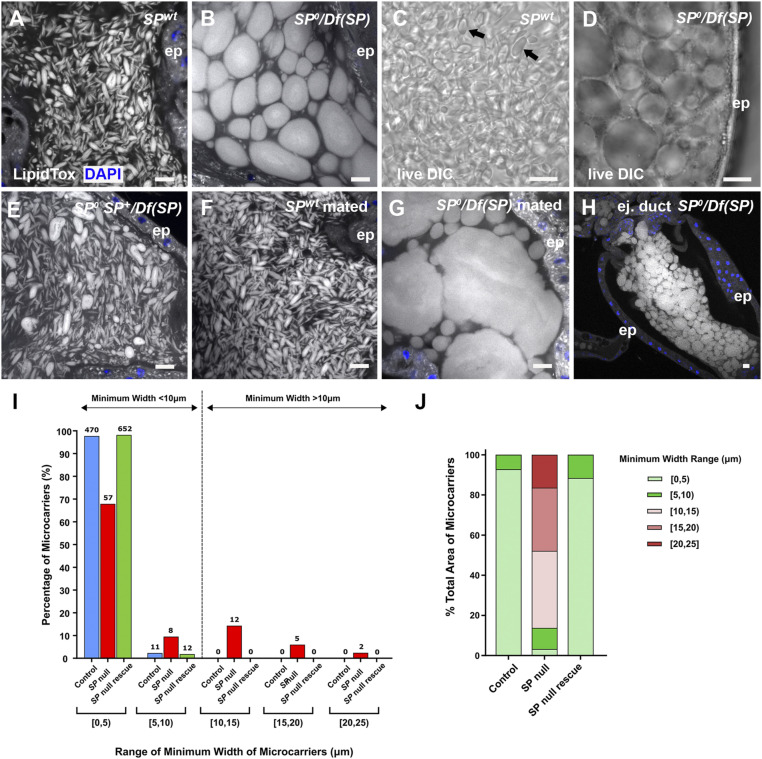
SP is essential for proper assembly of microcarriers. (A and B) Confocal images of LipidTox-labeled microcarriers in lumen of AG from control (A) and SP0/Df(SP) null (B) males. Mutant male has grossly enlarged microcarriers. (C and D) DIC images of living AGs dissected from control (C, black arrows) and SP0/Df(SP) (D) males. (E) Microcarrier structural defects in SP0/Df(SP) null males are rescued by a genomic SP construct SP0
SP+/Df(SP). (F and G) Microcarriers enlarge further after multiple matings in SP0/Df(SP) null (G), but not in wild-type (F) males. (H) In SP0/Df(SP) null males, these enlarged microcarriers are observed when seminal fluid remains in the lumen of the ejaculatory duct after mating. (I and J) Microcarrier size and area profiles for glands shown in A, B, and E. Microcarrier outlines were detected in images of the AG lumen using CellProfiler Software version 2.2.0 (Materials and Methods) and then grouped according to minimum width range (I) or percentage of luminal area occupied by microcarriers in each width range (J). Numbers of microcarriers within each size range are shown above bars (I). SP0/Df(SP) null glands have considerably fewer small microcarriers (<10 µm) and more large microcarriers (>10 µm) than the other genotypes. The enlarged microcarriers in SP0/Df(SP) null glands contain most of the lipid in the AG lumen, as estimated by LipidTox staining area. Nuclei marked with DAPI (blue). AG (A–G) or ejaculatory duct (H) epithelium (ep). (Scale bars: 10 µm.)